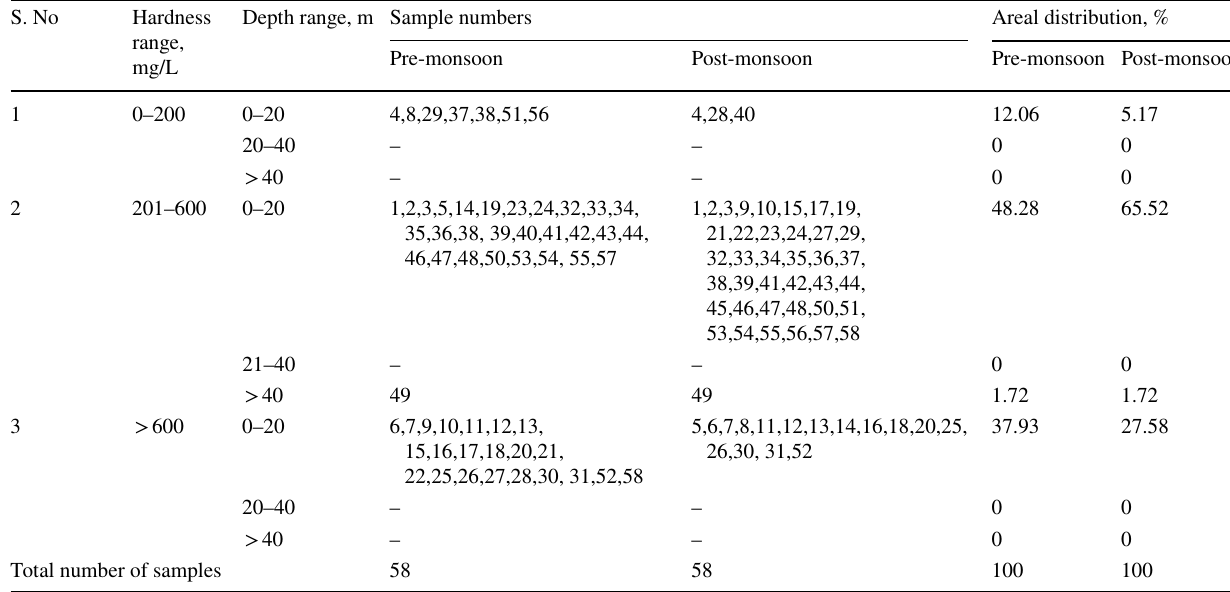
Table 6 Hardness distribution in groundwater of the study area S. No